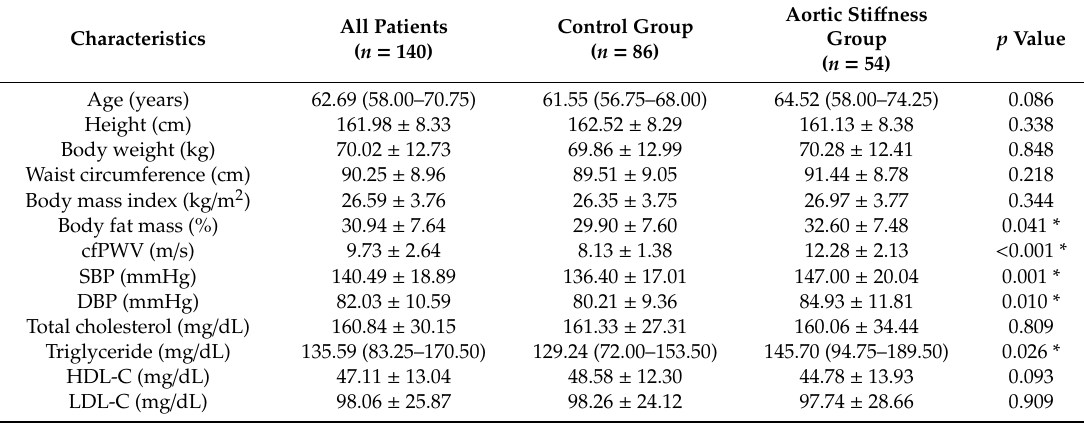
Table 1. Clinical variables of the 140 type 2 diabetes mellitus patients in the high aortic sti ff ness and control